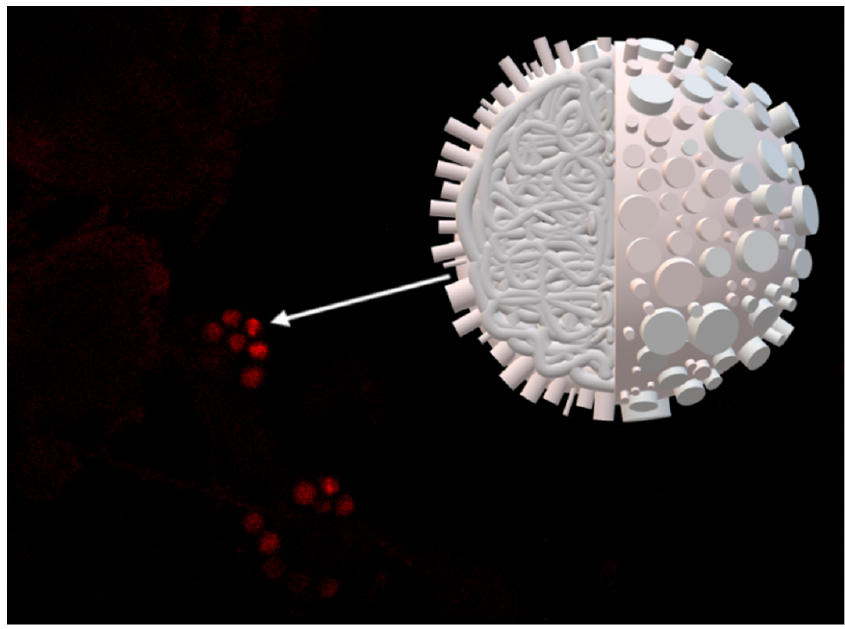
Figure 3. Structure of a single PHB granule [27].